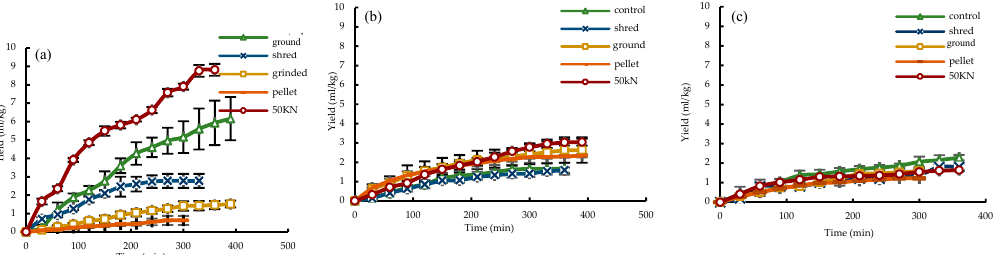
Figure 2. The yield of EOs extracted from untreated, shredded, ground, and densified (pellets and bundles) (50 kN) residual forest biomass: ( a ) balsam fir (BF), ( b ) black spruce (BS), and ( c ) jack pine (JP) by hydrodistillation.